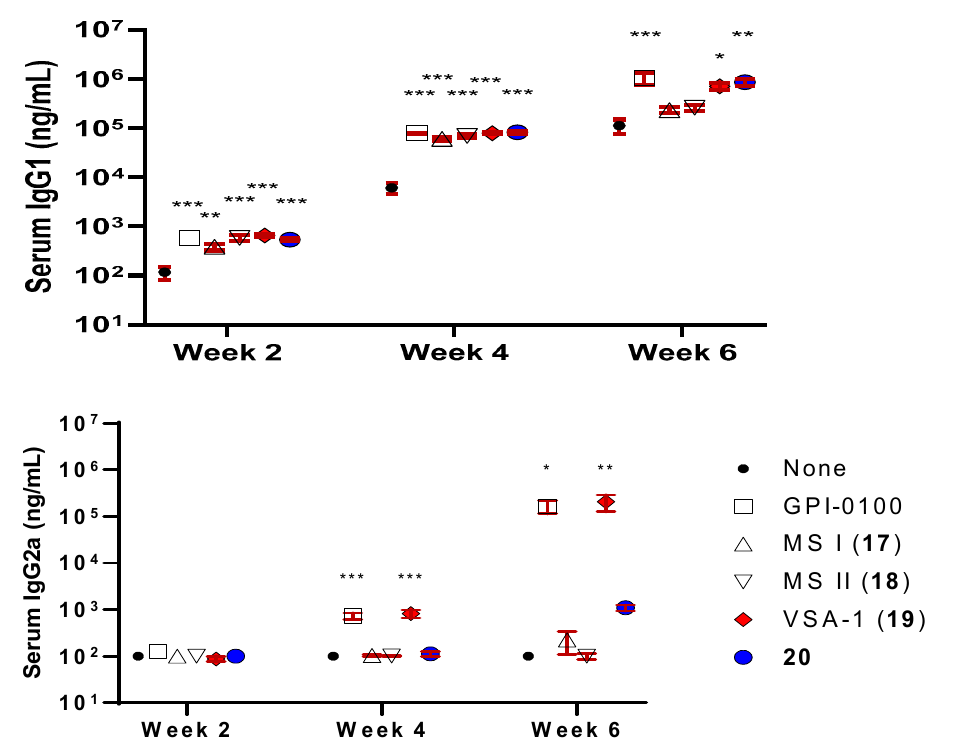
Figure 7. Serum IgG, IgG1, and IgG2a anti-OVA response in mice immunized by the s.c. route with OVA alone or with GPI-0100 or a saponin adjuvant. Mice were immunized on days 0, 14, and 28. Serum samples were collected prior to each immunization and at 6 weeks following the initial immunization. Values are expressed as mean ± SEM. * p < 0.05, ** p < 0.01, and *** p < 0.001 compared with mice immunized with OVA alone.